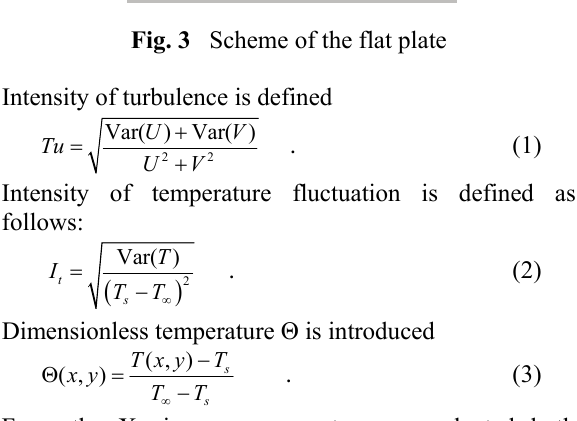
Fig. 5 Dimensionless velocity profiles V/U x =(100 − 900) mm. Unheated plate. Measured values of vertical dimensionless velocity were under 0.01, as one can see from graph in V/U ∞ fig. 5. It proves assumption given above, that vertical and horizontal component differ by two orders of